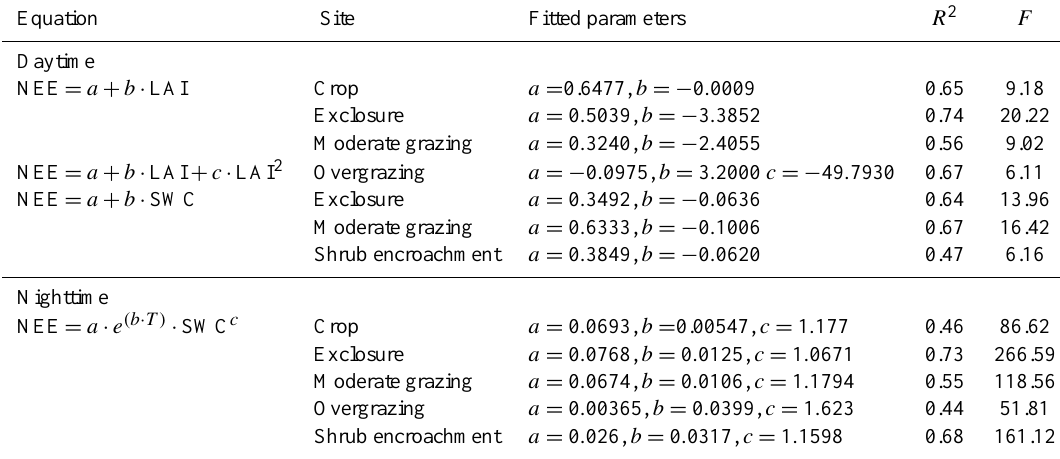
Table 4. Fitted relationships between daytime and nighttime NEE with leaf area, soil moisture, and air temperature. Equation Site Fitted parameters R 2